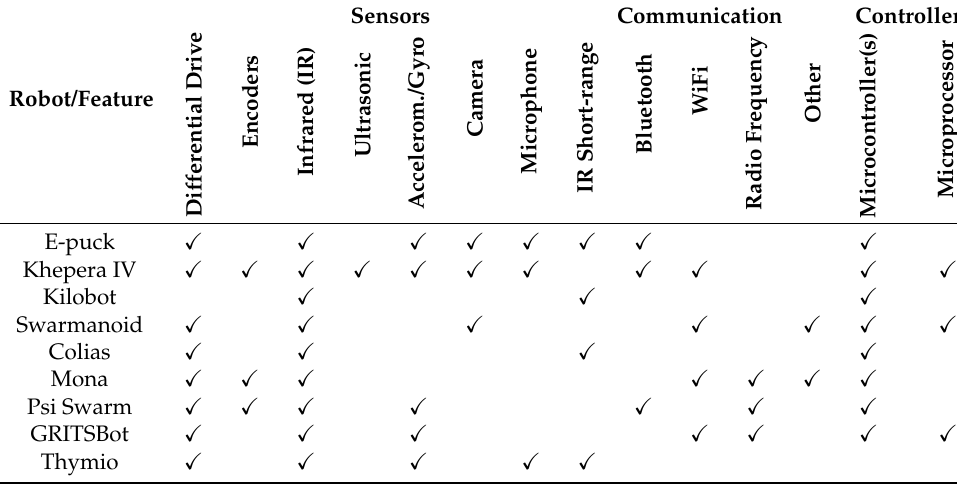
Table 3. Hardware features of main robots for swarm use. Sensors